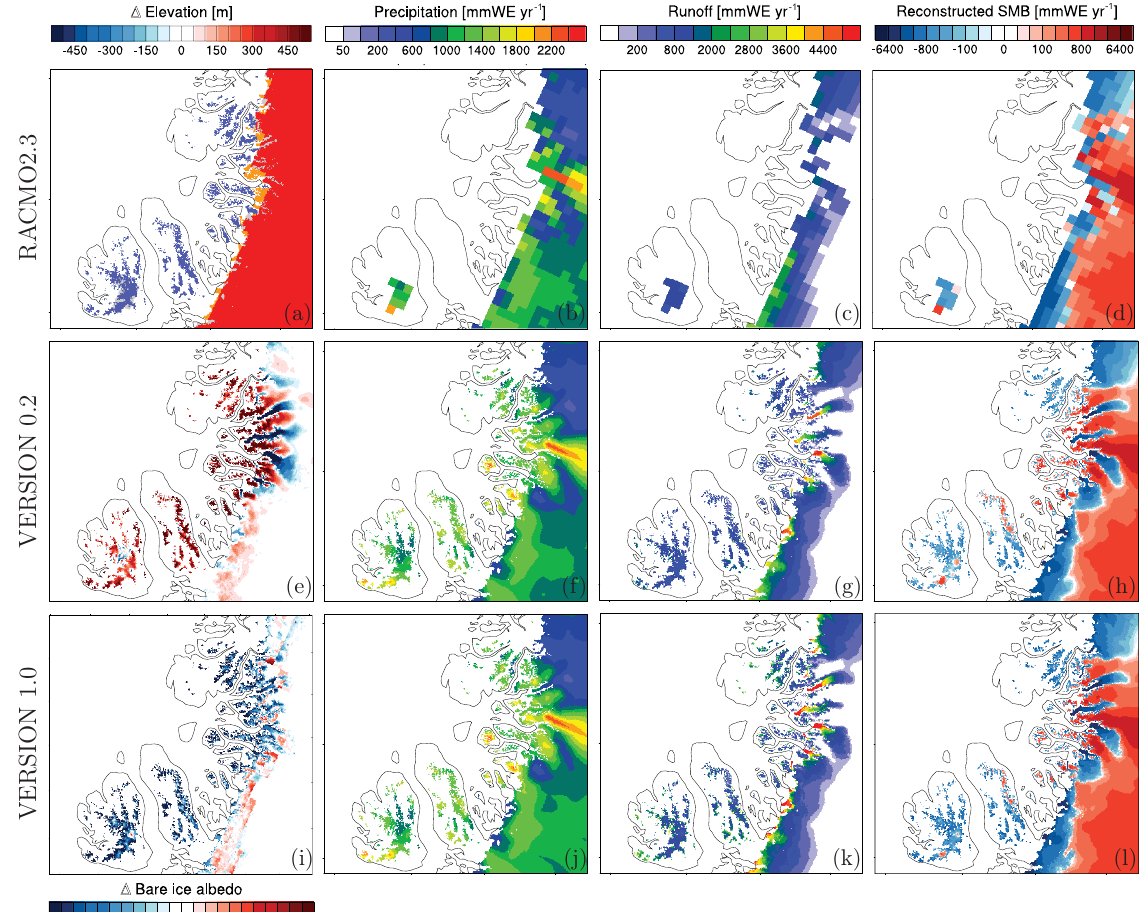
Figure 11. Centre west: same as Fig. 10 but for central west Greenland (blue box 2 in Fig.